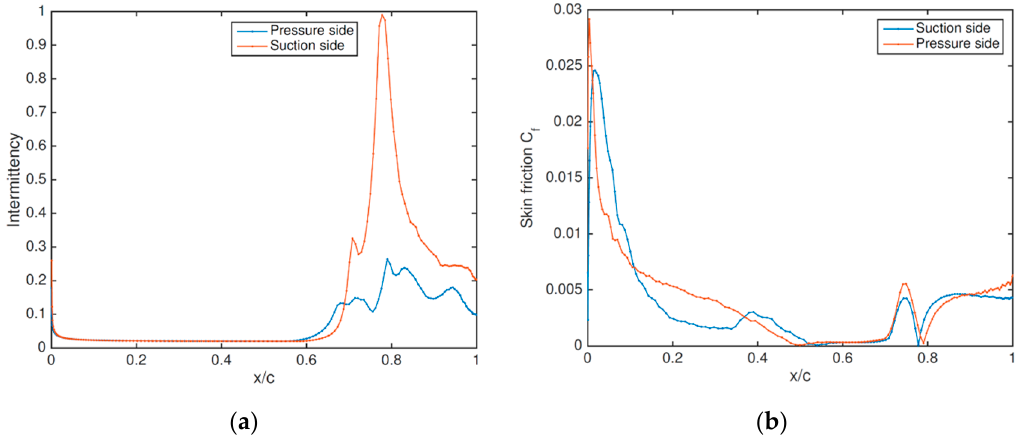
Figure 20. Intermittency ( a ) and skin friction ( b ) distribution on the airfoil in clean flow.